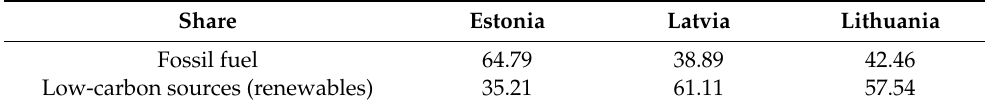
Table 2. Share of electricity production (%) in the Baltic States in 2020. Fossil fuel, low-carbon sources (solar, wind, hydropower, biomass, waste, geothermal, wave, tidal) [38]. Share